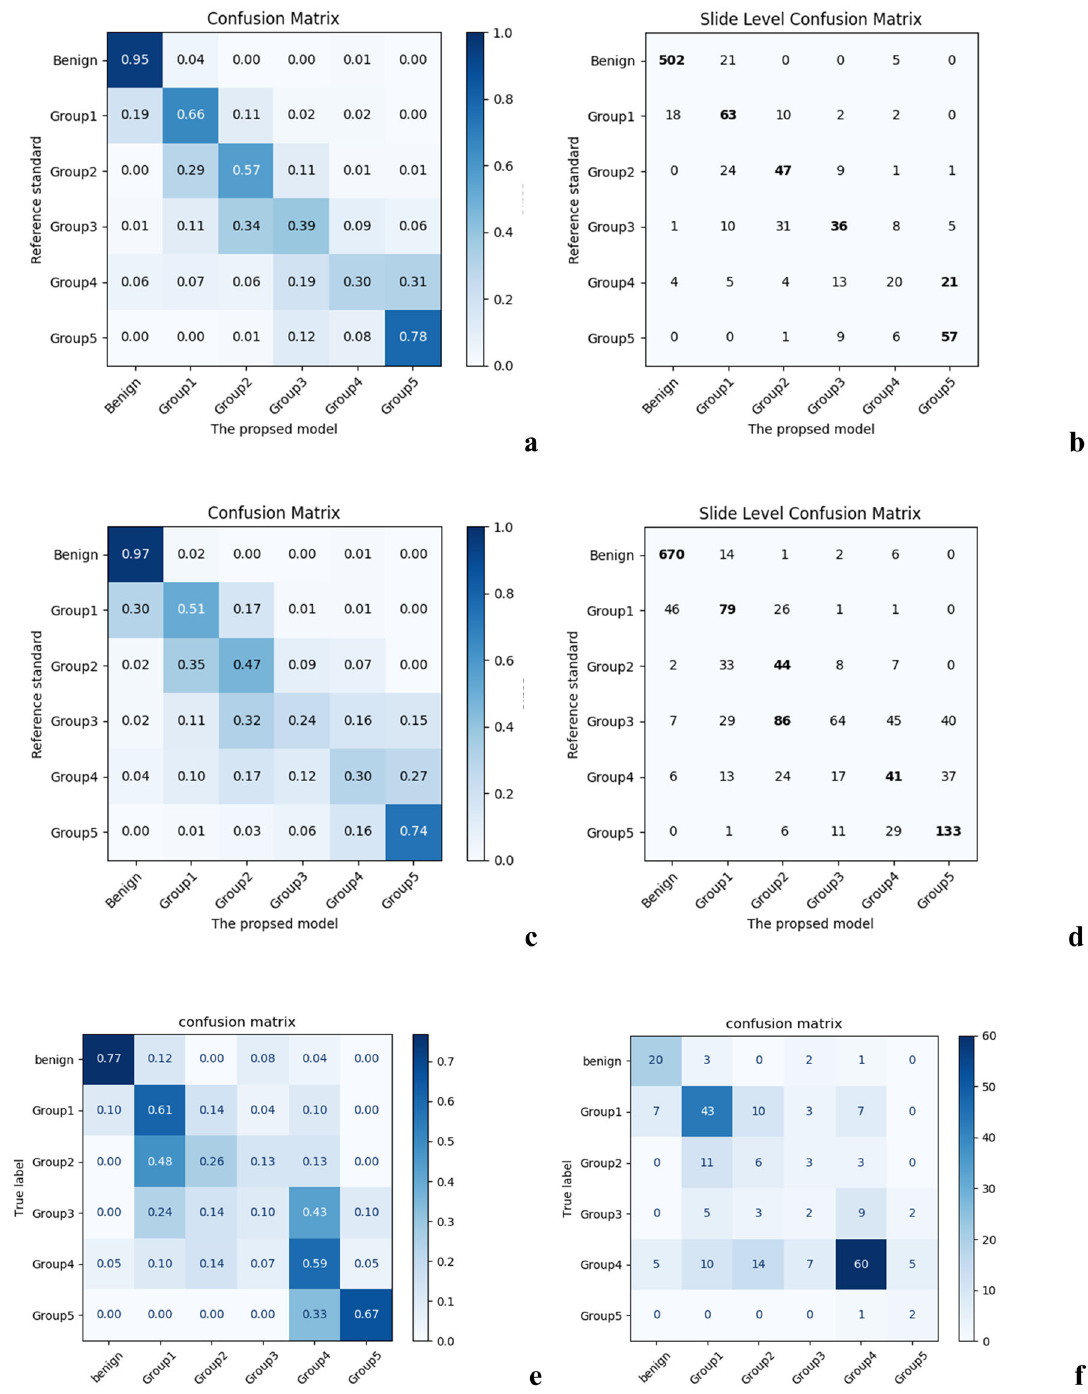
Fig. 1 Slide-level confusion matrices between the proposed model and the reference standard in grade group prediction in the holistic setting. a normalized, b original; in the inter-institutional setting: c normalized, d original; in the external validation setting: e normalized, f